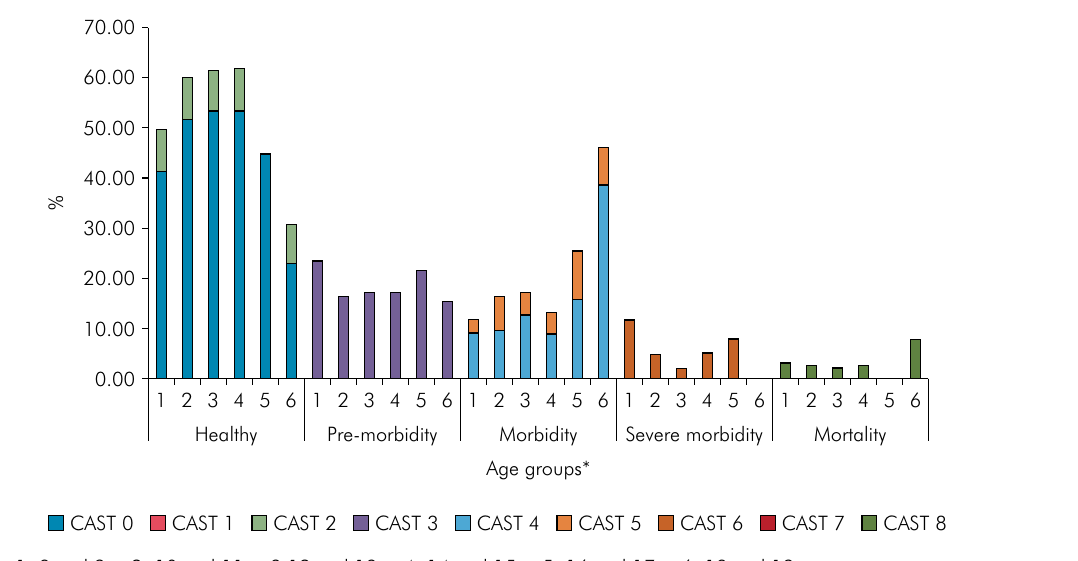
Figure 1. Percentual distribution of CAST components as per the category of severity in each age